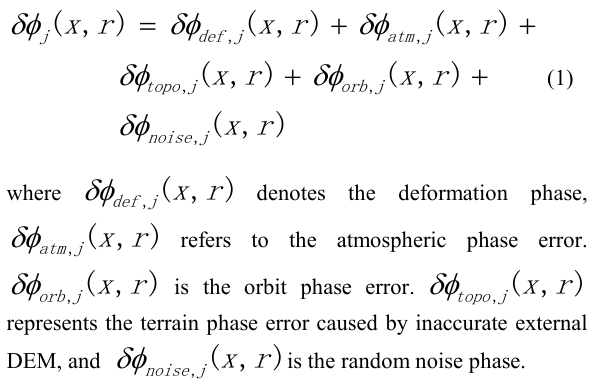
Figure 2. Flow diagram of the PSInSAR technique Supposing N SAR images are captured. Firstly, a SAR image was selected as the master image. Then, all the slave images were co-registered and resampled to the master image, and N-1 interferograms can be obtained by differential interferometric Figure 1. Location of study area. The black rectangle denotes processing using external DEM and other data. In this study, the the study area of this work. SAR image acquired on 14 October 2009 was selected as the master image and 17 pairs of interferograms were generated (Figure 3). According to the actual situation of the study area and SAR images, the corresponding PS point screening method was selected to obtain PS points in the study area. The interferometric phase of a pixel located at coordinates ( x, r ) in interferogram j can be expressed as